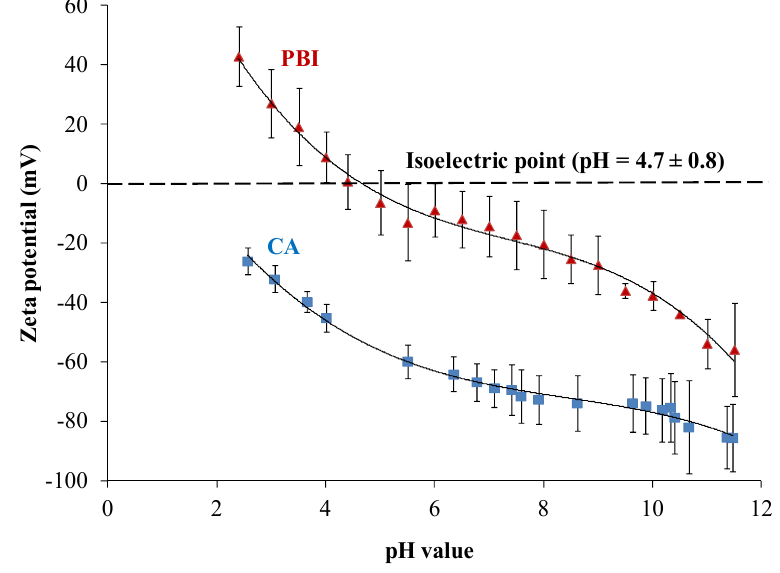
Figure 5. Chemical structures of ( a ) polybenzimidazole and ( b ) POSS